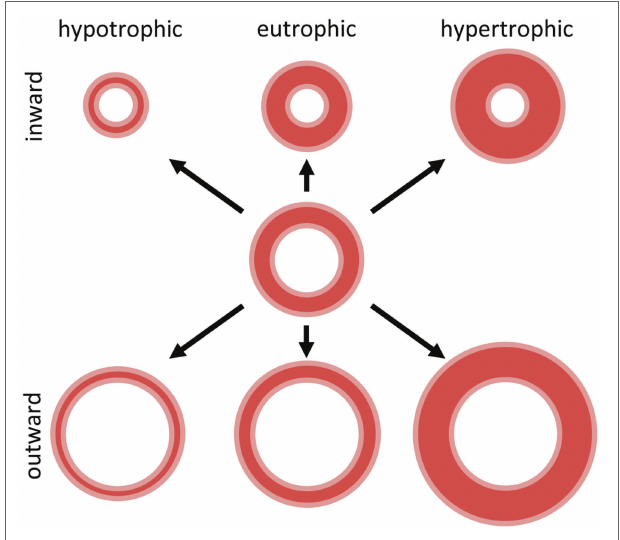
FIGURE 2 | Schematic representation of inward and outward hypotrophic, eutrophic and hypertrophic vascular remodeling. Adapted with permission from Mulvany et al.